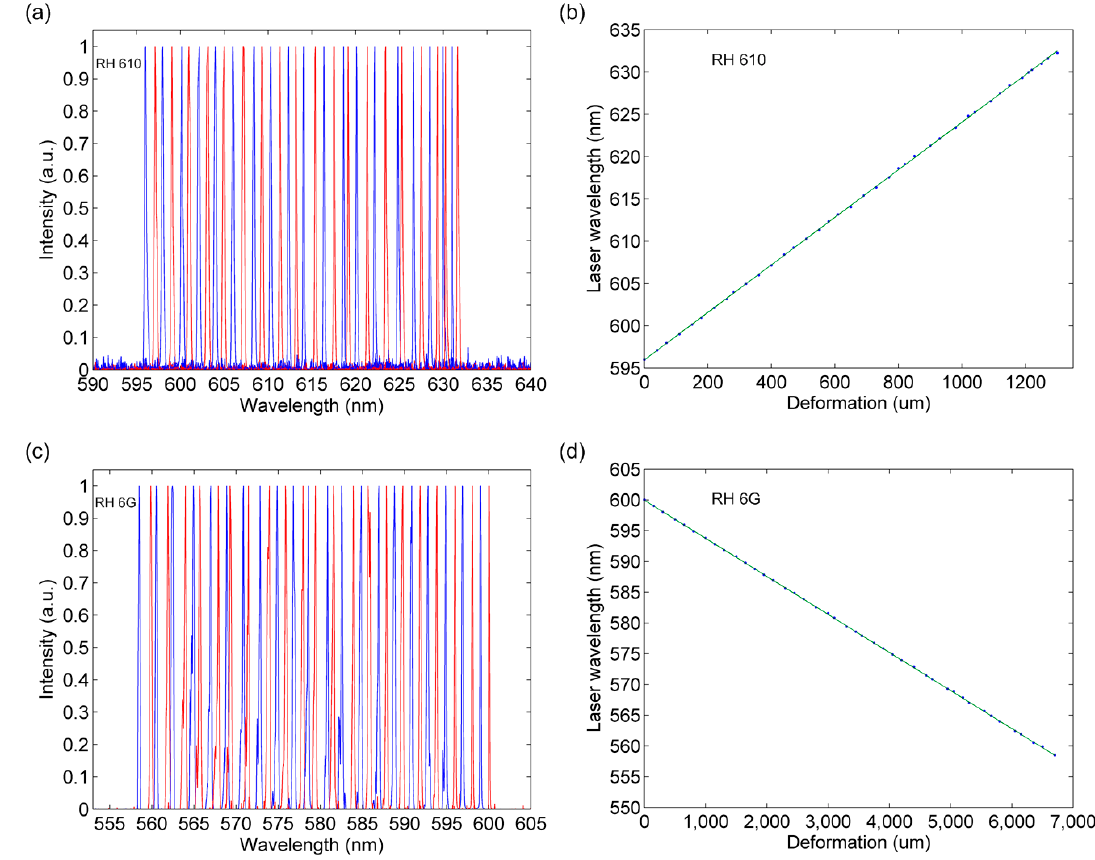
Figure 5. Normalized lasing spectra of DFB film dye lasers in ( a ) perpendicular stretching mode (RH 610) and ( c ) parallel stretching mode (RH 6 G). The relationship of output laser wavelength vs. film deformation in ( b ) perpendicular stretching mode (RH 610) and ( d ) parallel stretching mode (RH 6 G).